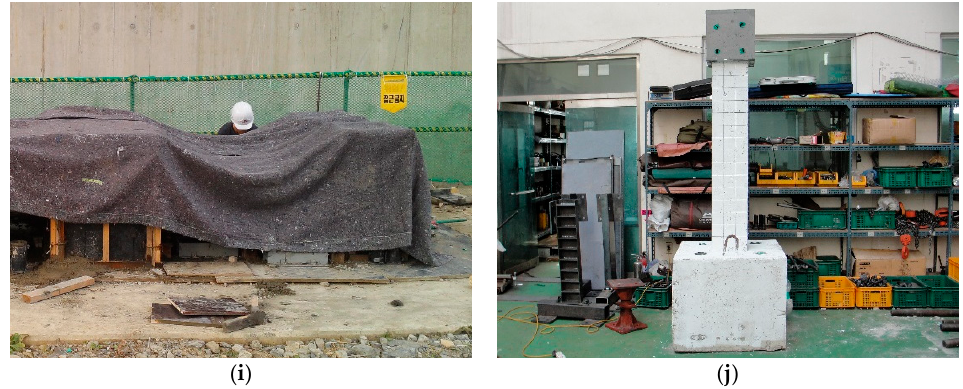
Figure 4. Manufacturing process of column specimens ( a ) Formwork ( b ) Rebar installation ( c ) Strain gauges installation ( d ) ECC mix ( e ) Mixed ECC ( f ) Placement of ECC ( g ) Placement of concrete ( h ) Finish ( i ) Curing of specimen ( j ) Manufactured specimen.